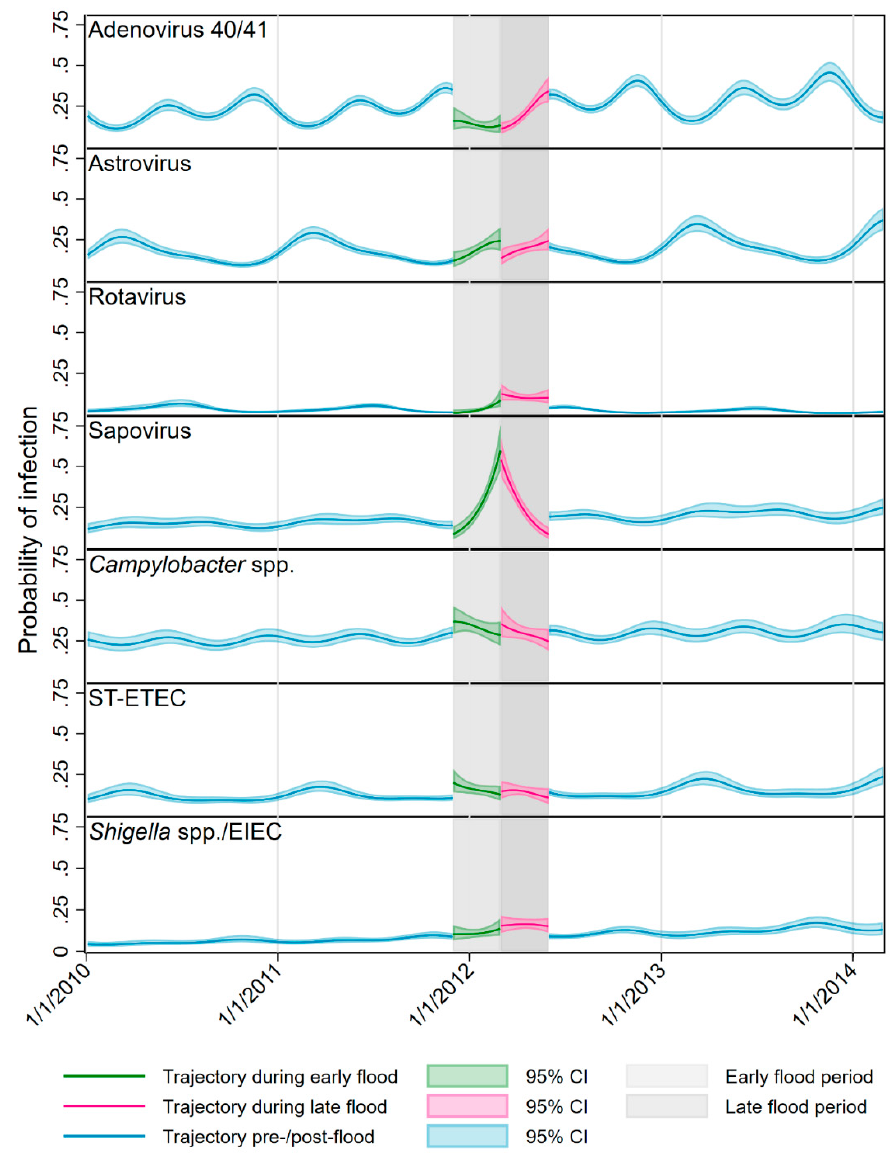
Figure 5. Transmission trajectories predicted by the models with (confidence intervals—CIs) for the seven pathogens that exhibited statistically significant e ff ects (probabilities calculated from relative risk estimates).